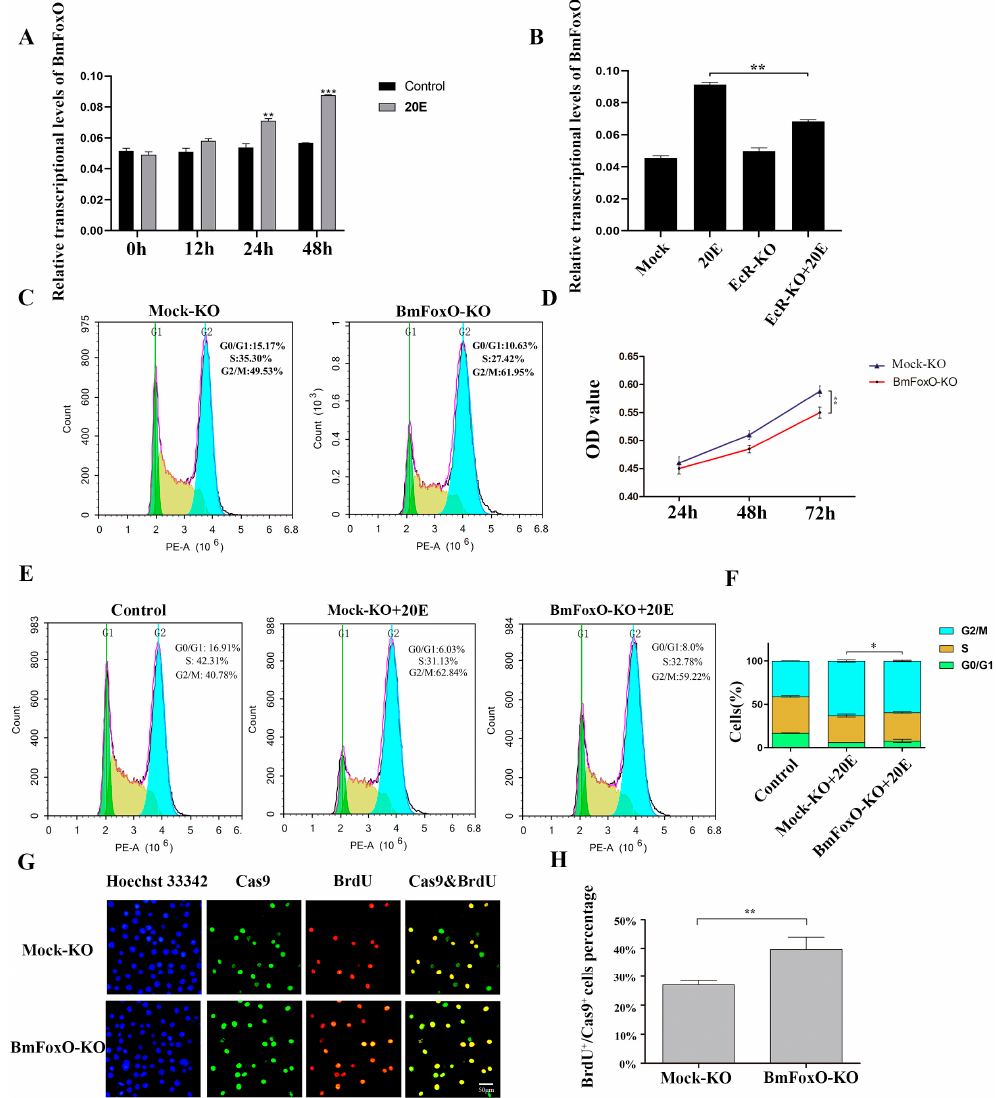
Figure 3. BmFoxO gene deficiency impairs cell cycle regulation by 20E. ( A ) The transcriptional levels of BmFoxO gene after 0.25 μ g/mL 20E induction at 0 h, 12 h, 24 h, and 48 h were analyzed by qRT-PCR (* p < 0.05, ** p < 0.01, *** p < 0.001). ( B ) The transcriptional levels of BmFoxO gene in BmN-SWU1 cells incubated with 0.25 μ g/mL 20E for 24 h after transfection with Cas9-BmEcR sgRNA recombinant plasmid (EcR-KO)